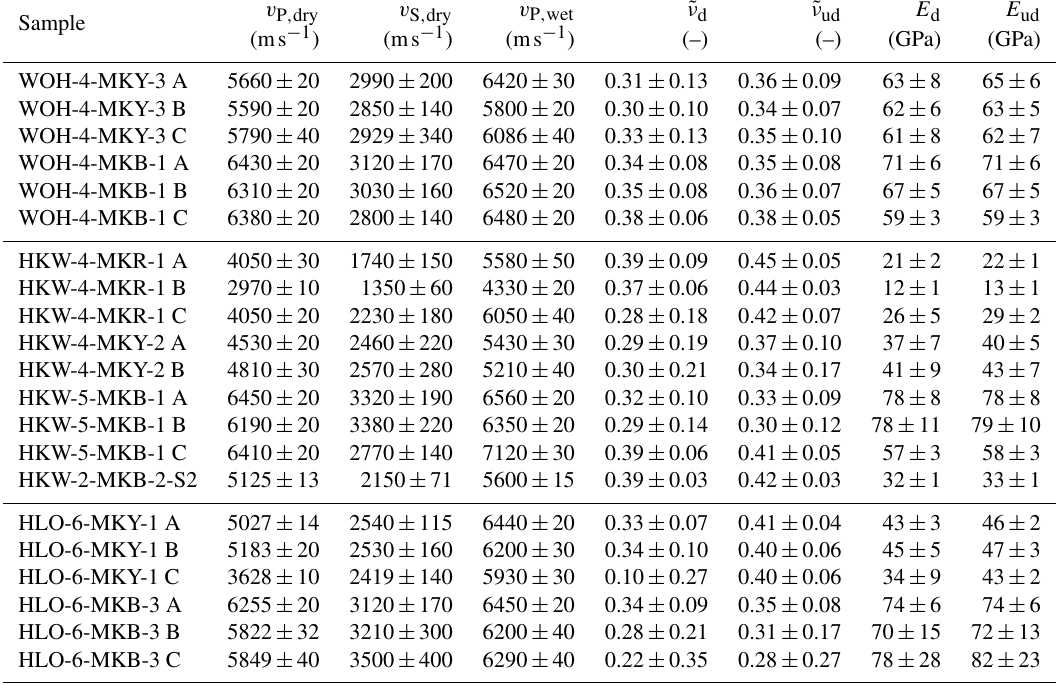
Table 5. Ultrasound velocities and dynamic elastic moduli derived by laboratory measurements for limestone and dolomite samples from Wuppertal (WOH), Hagen-Hohenlimburg (HKW), and Hönnetal (HLO). The abbreviations MKY, MKB, and MKR indicate the coloured rock types Massenkalk yellow (dolomite), Massenkalk black (limestone), and Massenkalk red (dolomite), respectively.